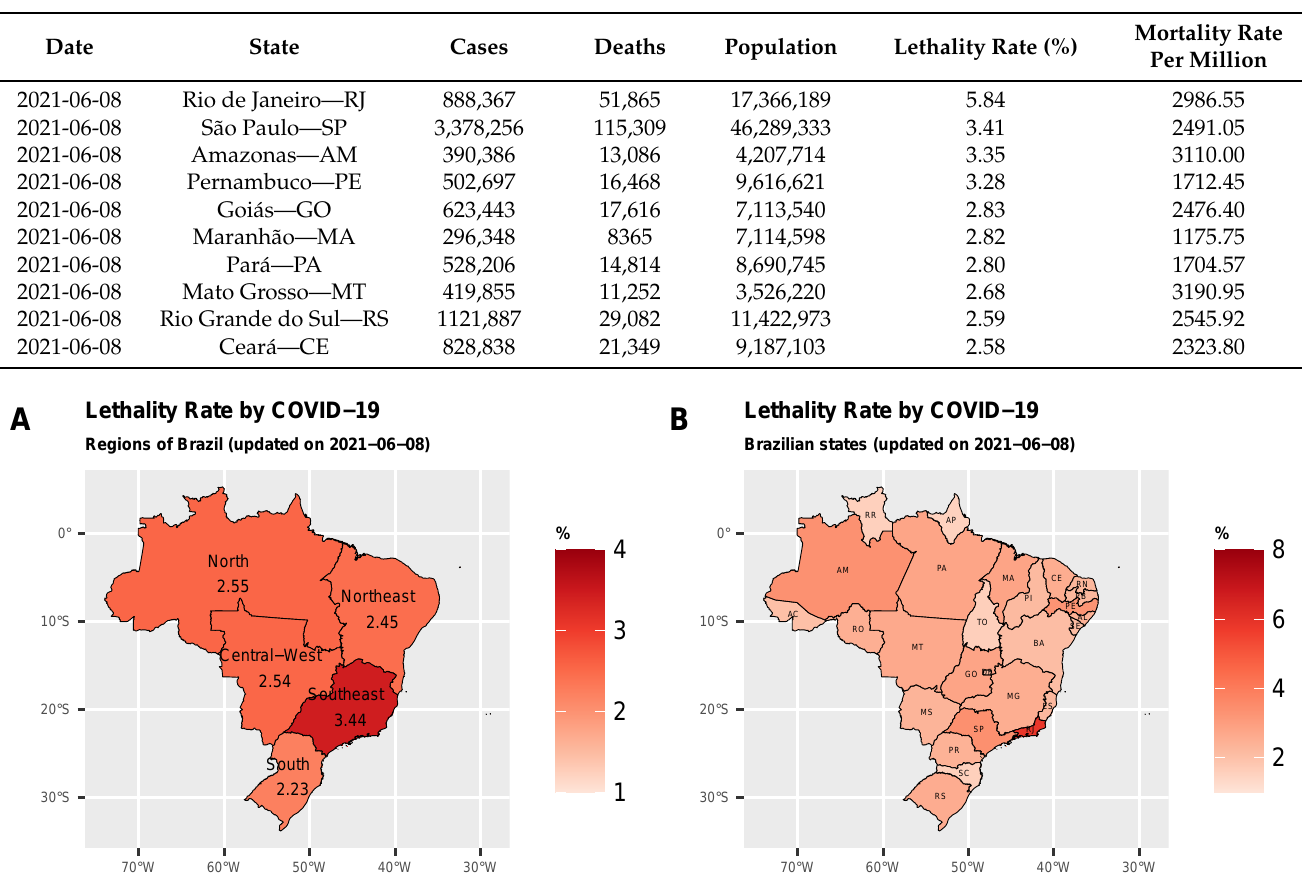
Table 2. COVID-19 statistics for the ten Brazilian states with the highest lethality rate (update on 2021-06-08).